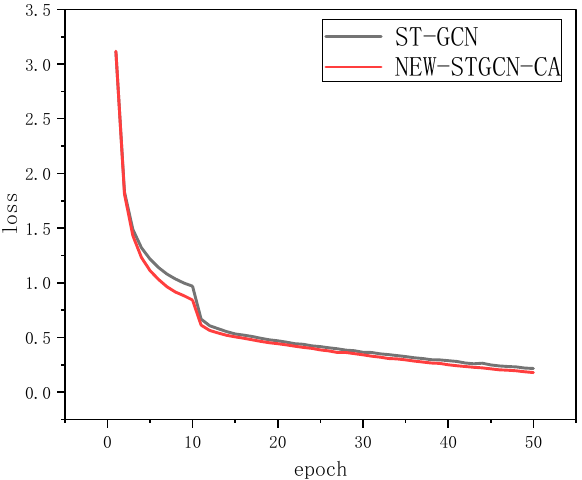
Figure 7. Change curve of loss values.